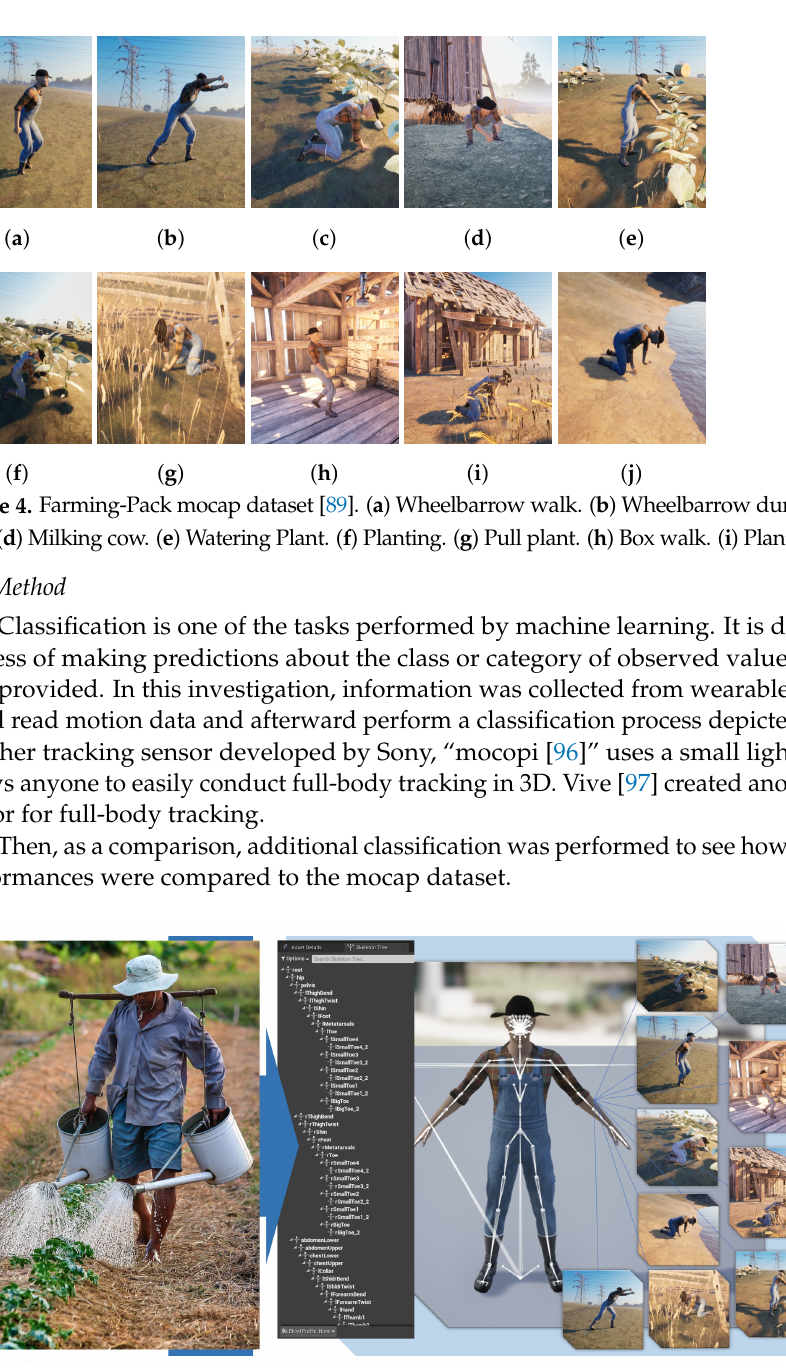
Figure 5. How to train the